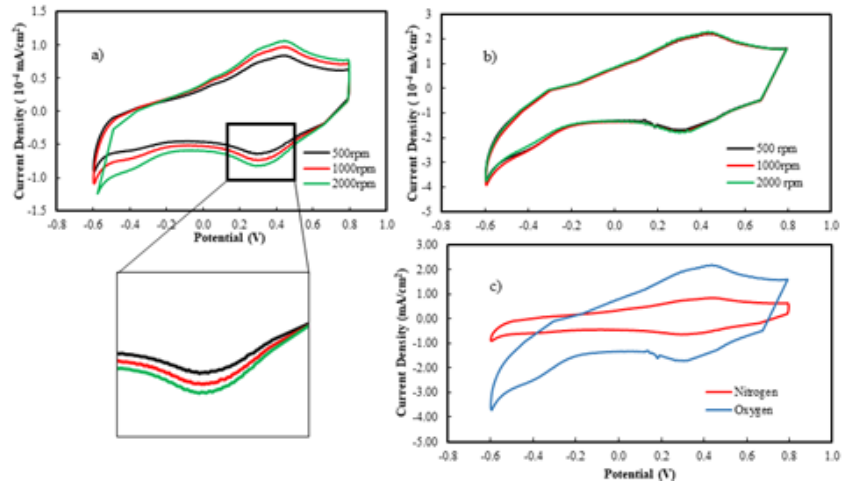
Fig. 4. NDG-12hr cyclic voltammogram (a) N2 Saturated; (b) O2 Saturated; (c) 500 RPM comparison.